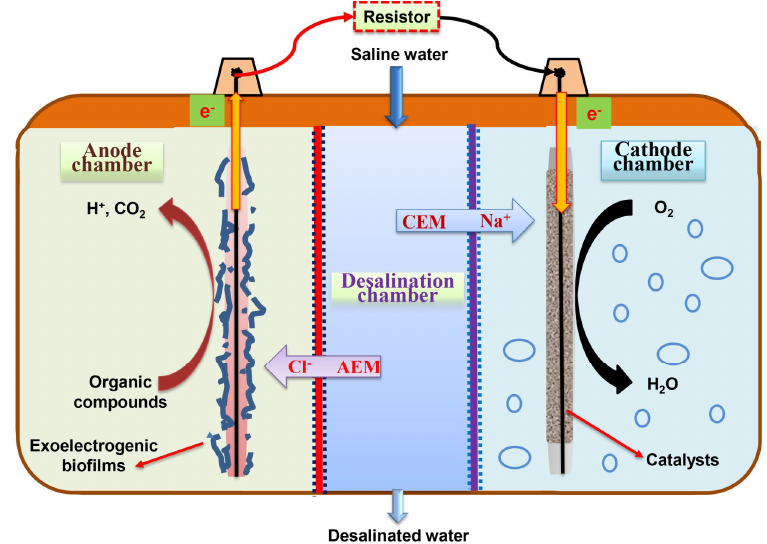
Figure 3. Schematic of a microbial desalination